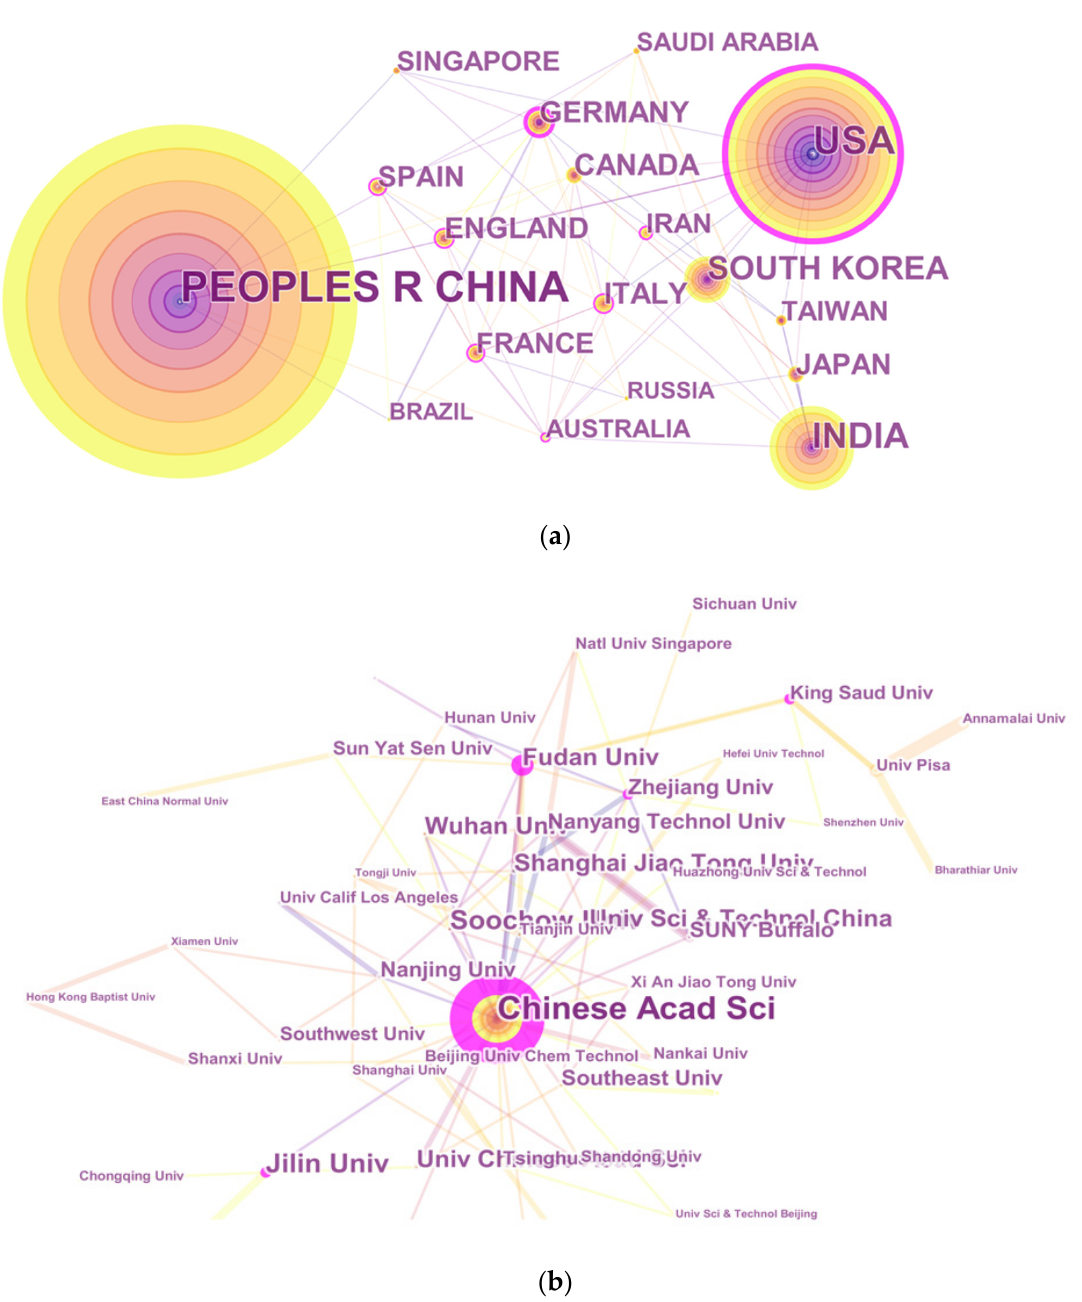
Figure 3. The analysis of countries/territories and institutions. ( a ) Network map of countries/territories engaged in QDs toxicity research; ( b ) Network map of institutions engaged in QDs toxicity research. Table 2. The top 10 countries and institutions that contributed to publications on QDs toxicity research.